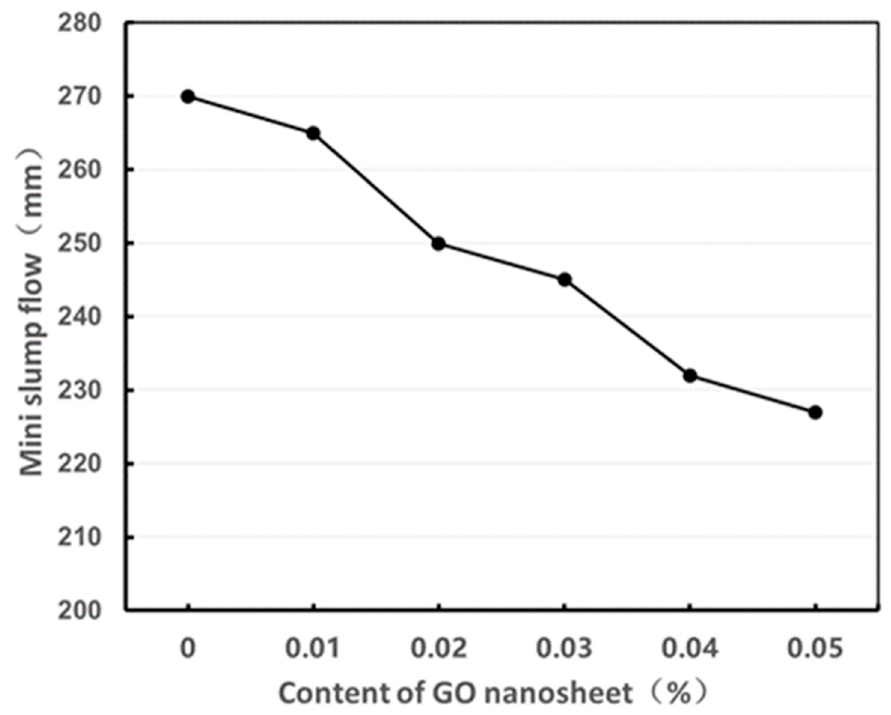
Figure 4. Mini slump flow of UHPC with different GO nanosheet contents.